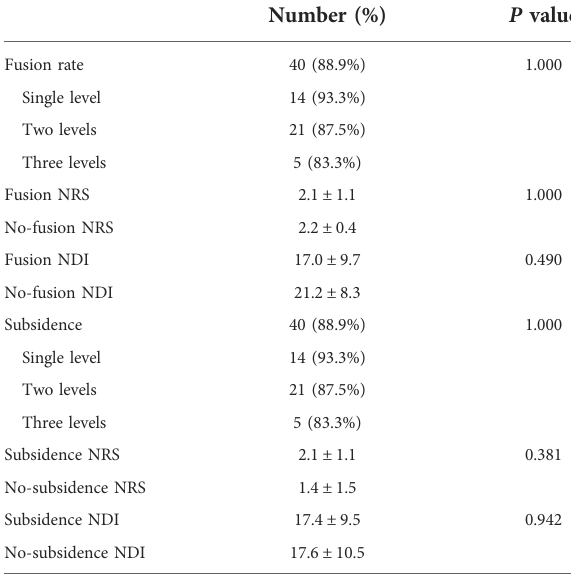
TABLE 3 Clinical and radiological